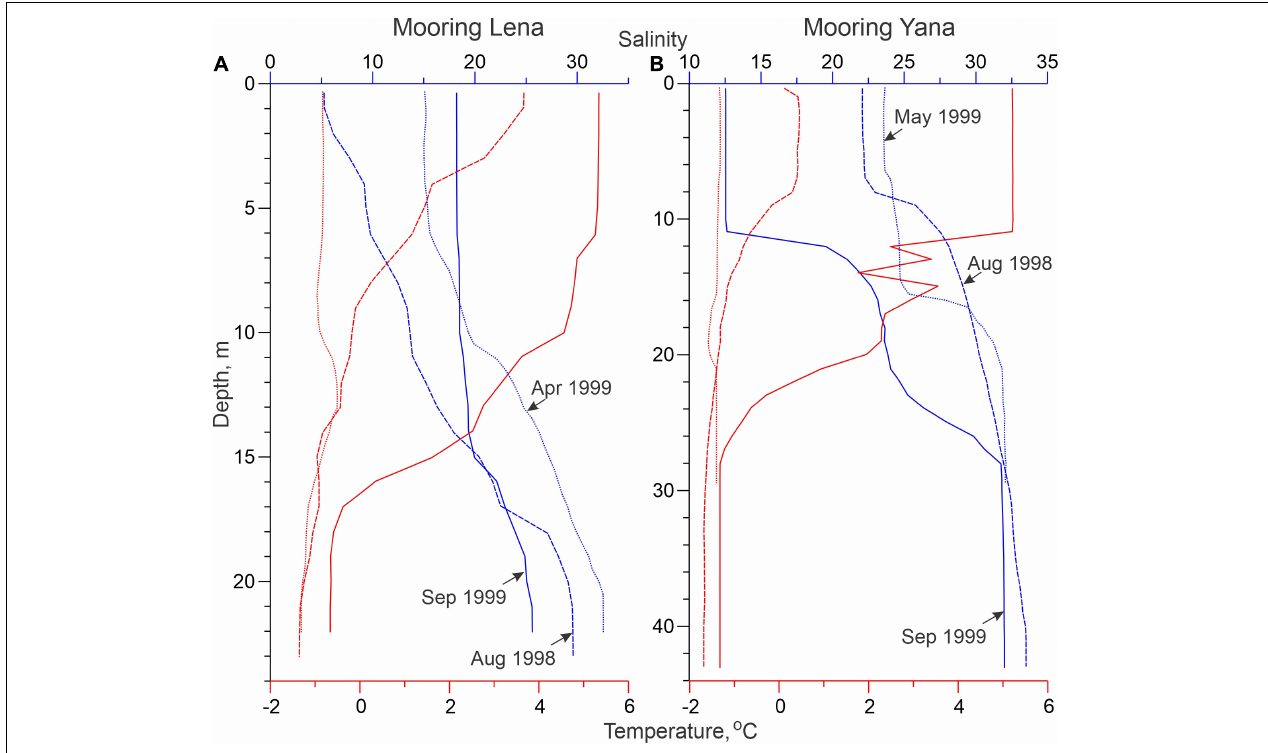
FIGURE 2 | Vertical profiles of salinity (blue) and temperature (red, ◦ C) taken at mooring deployment (solid line; August 1998) and recovery (dashed line; September 1990), and in April–May 1999 (dotted lines) at moorings (A) Lena and (B) Yana. Note that the CTD profile at Yana in May 1999 was taken approximately 10 km eastward from mooring location.